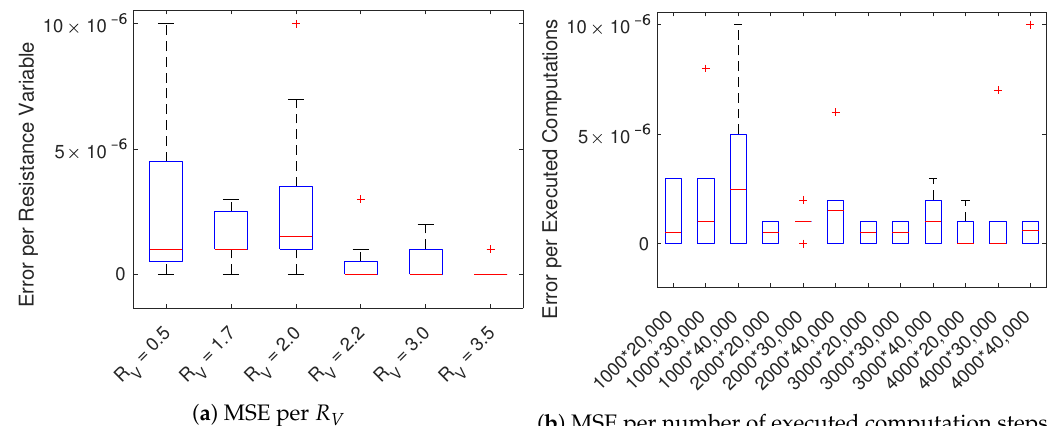
( b ) MSE per number of executed computation steps Figure 4. Boxplots of the mean squared error E of the variable u among CPU and GPU solutions. Panel ( a ) are sampled per R V over increasing number of executed computations ( N ∗ T ) while panel ( b ) per number of executed computations ( N ∗ T ) over varying R V